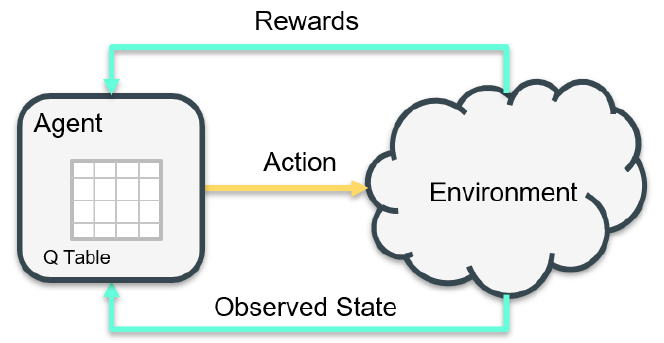
Figure 4. Q Learning.